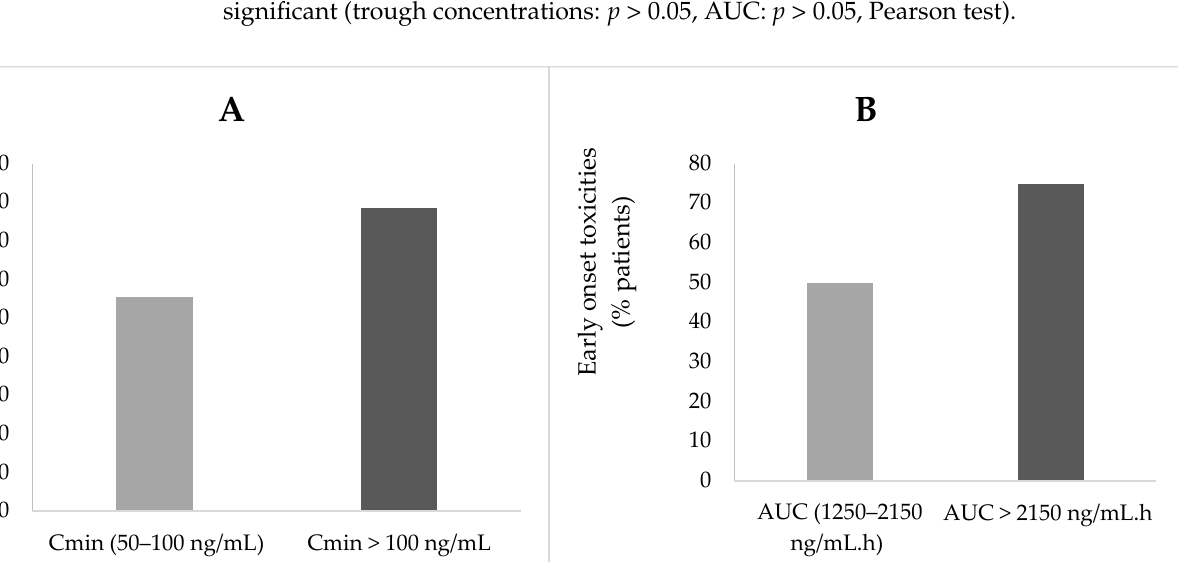
Figure 4 . ( A , B ) Relationships between clinical issues and concentration trough levels (A) or drug exposure (B). No statis- tical difference was found in Cmin or AUC values between patients with clinical benefit and patients with progressive disease.